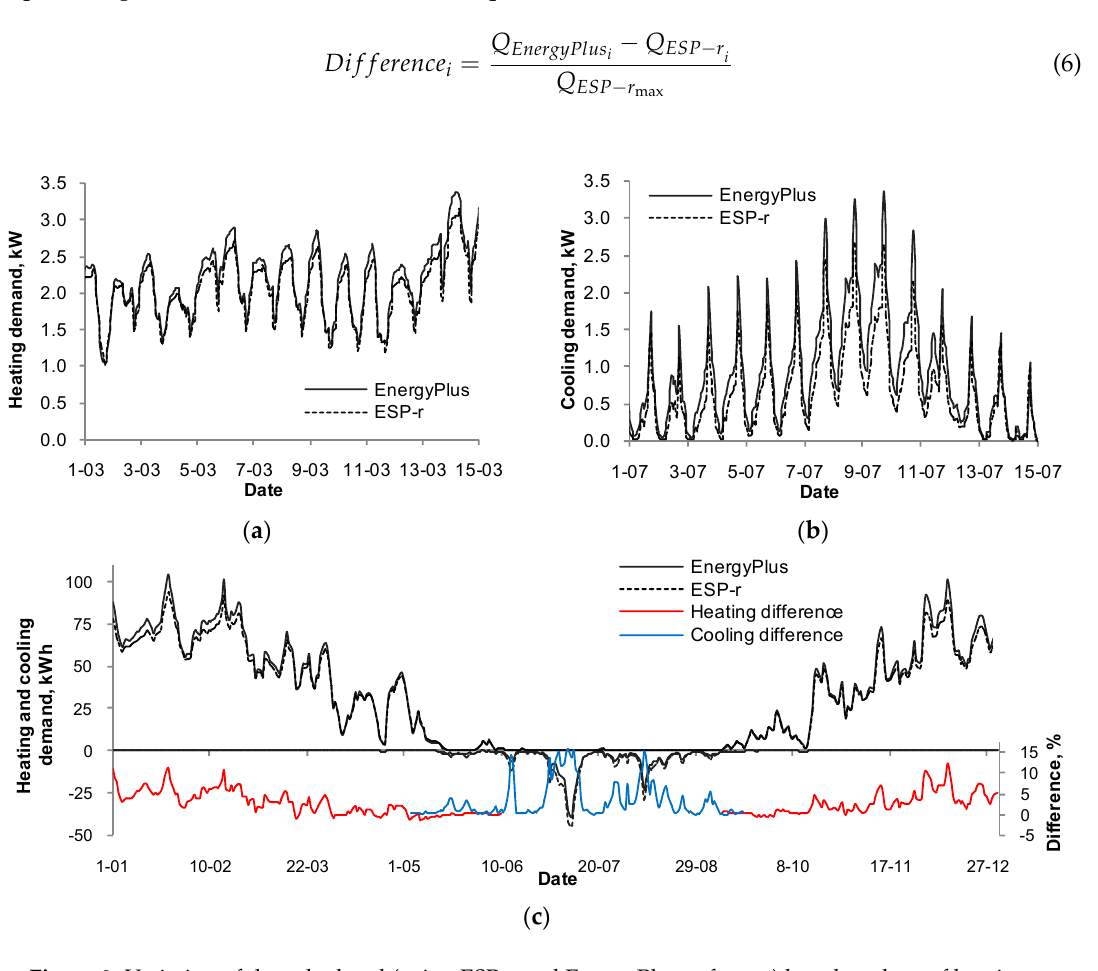
Figure 3. Variation of the calculated (using ESP-r and EnergyPlus software) hourly values of heating demand in March ( a ) and cooling demand in July ( b ) and daily heating (positive values) and cooling (negative values) demand in the whole year ( c ).